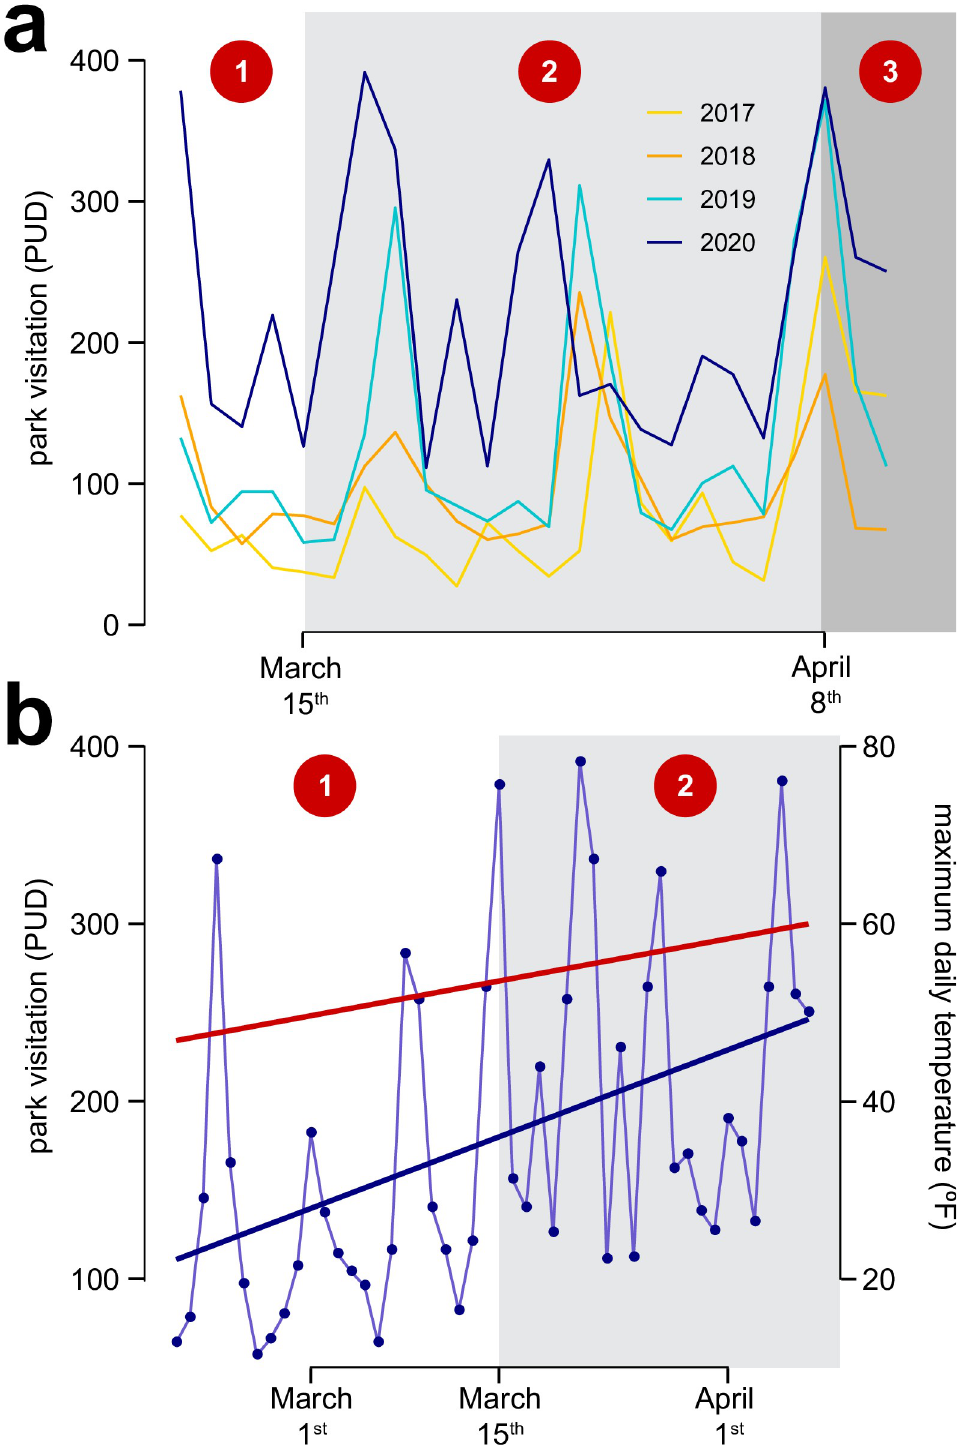
Fig 3. The effects of the onset of the COVID-19 pandemic on park visitation (as measured by PUD, photograph user days). (a) Park usage during mid-March through early April of 2020 was higher relative to previous years, and (b) park visitation increased when the stay-at-home order was put into effect, even after controlling for temperature increases. The red trendline in (b) corresponds to temperature trends during this interval, whereas the blue trendline corresponds to the overall trend in park visitation. The numbers in red circles refer to the time periods denoted in Fig 1.